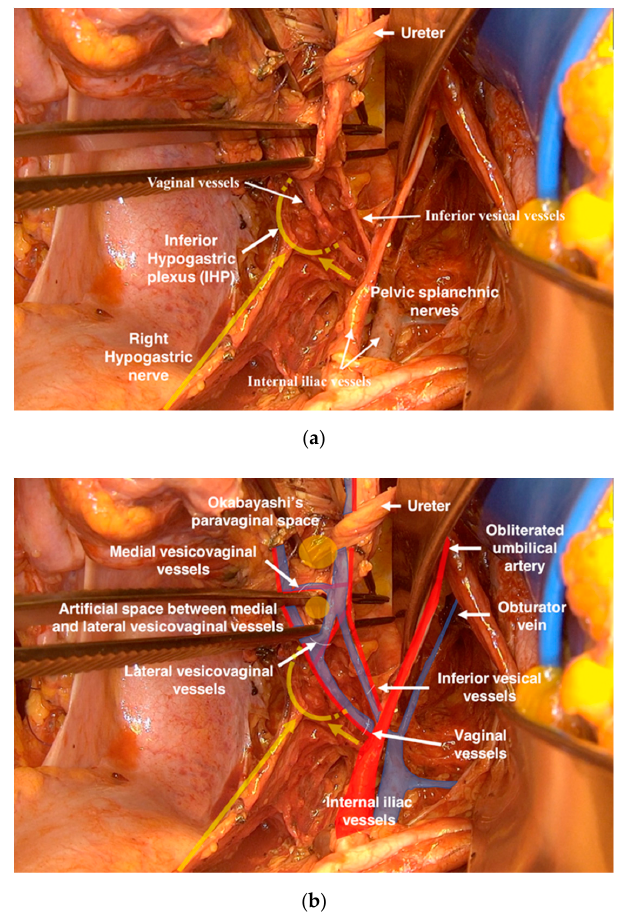
Figure 6. ( a ) The adherent localization between lateral and ventral paracolpium and the pelvic splanchnic nerves and inferior hypogastric plexus. ( b ) The vascular anastomoses between vaginal vessels and inferior vesical vessels in the ventral